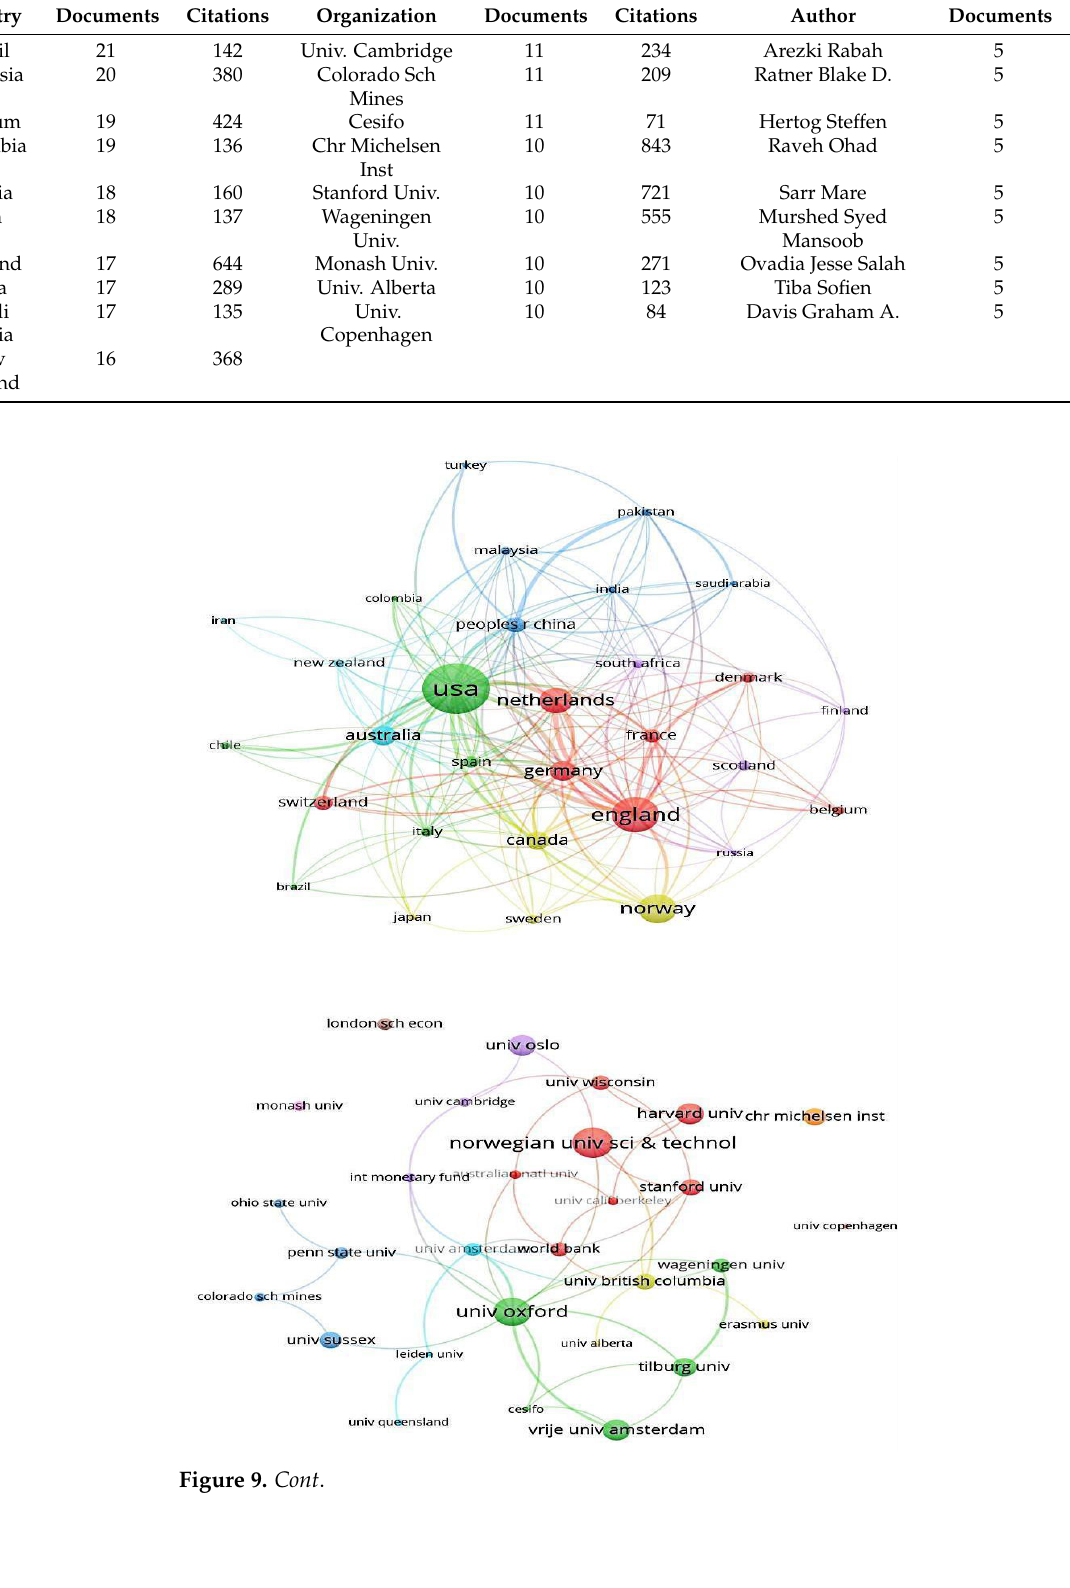
Figure 9. Comparison of the publication number by top30 countries, top 29 institutions, and top 29 authors (using VOSviewer).